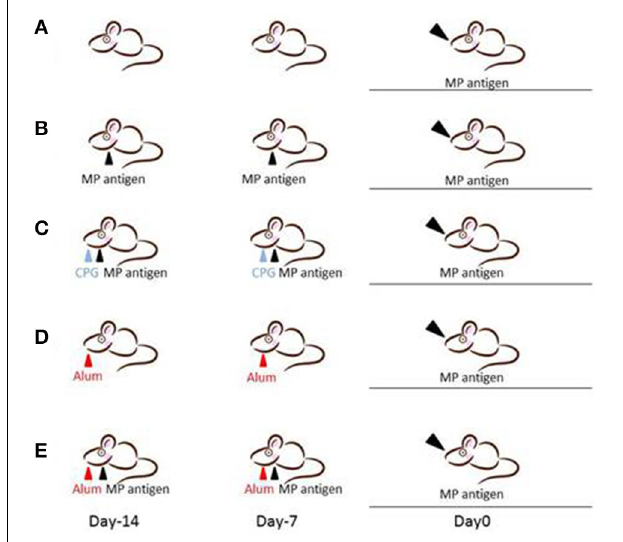
FIGURE 1 | Female BALB/c (7-week-old) mice were inoculated intratracheally with Mp antigen with or without pre-immunization. Pre-immunization was carried out by intraperitoneal injection at 7 and 14 days prior to the intratracheal (IT) challenge. Model A: IT without pre-immunization. Model B: IT after twice pre-immunizing with Mp antigen alone. Model C: IT after twice pre-immunizing with Mp antigen plus CpG. Model D: IT after twice pre-immunizing with alum alone. Model E: IT after twice pre-immunizing with Mp antigen plus alum. One week following the last immunization, mice underwent IT with 50 μ g of Mp antigen. Bronchoalveolar lavage fluid (BALF) and lung specimens were obtained before this process and 8, 24, 48, 96, and 168h after IT. Mp: